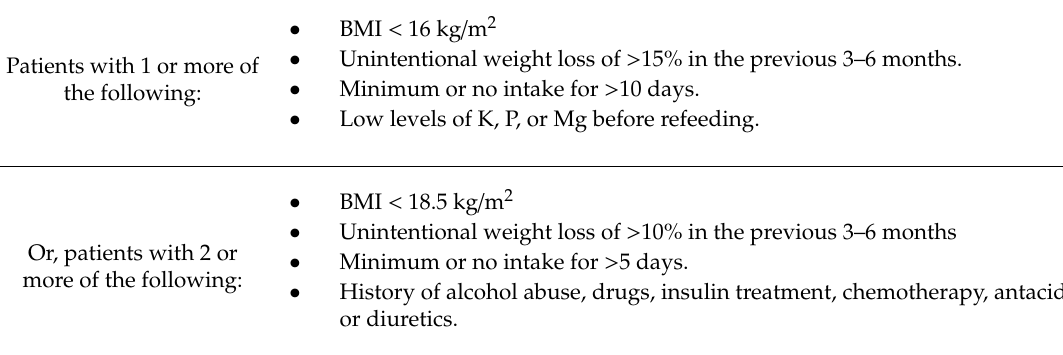
Table 7. Identification of patients with high risk of refeeding